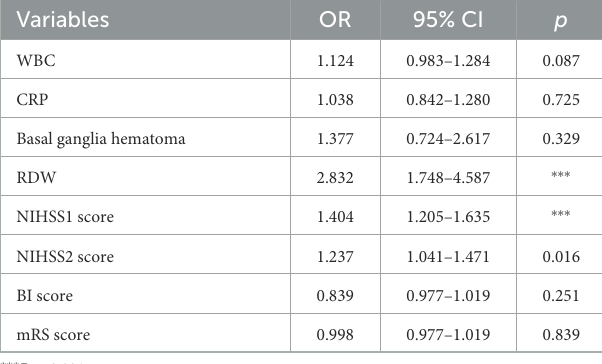
TABLE 4 Multivariate logistic regression analysis for ICH patients’ depression. Variables